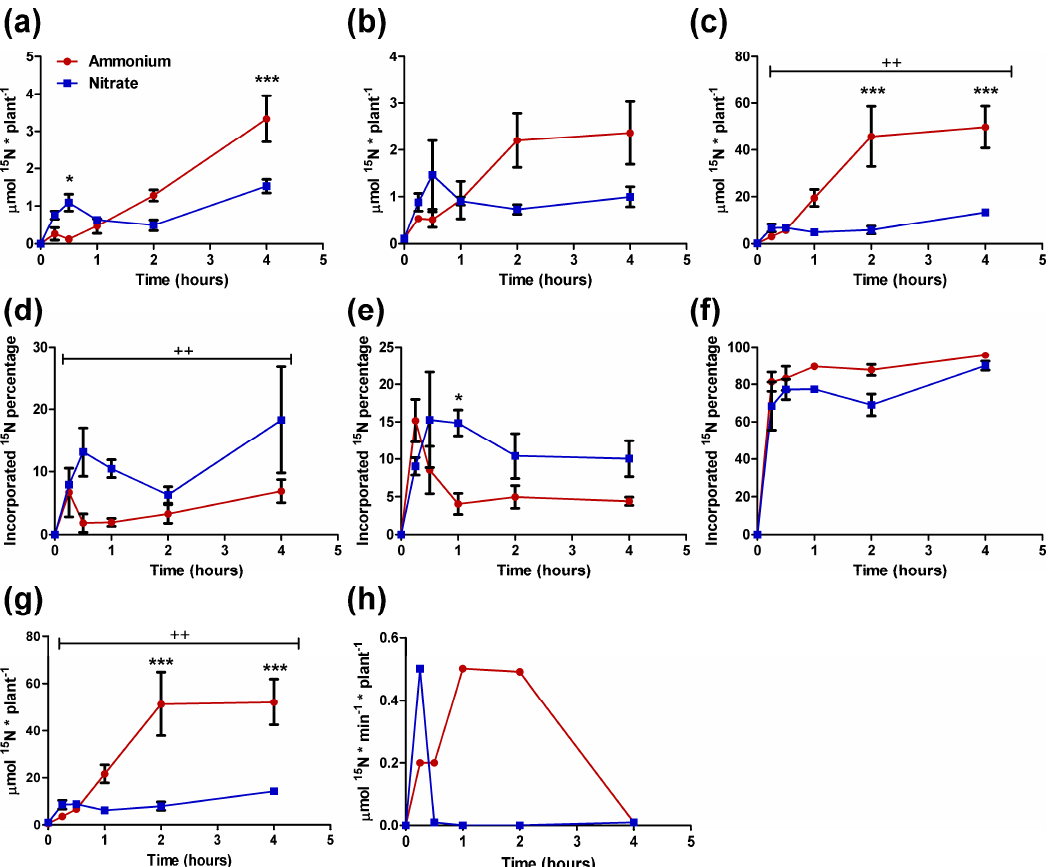
Figure 3. 15 N incorporation in different organs (needles, stem, and roots) of pine seedlings under the two nutrient treatments. The red line corresponds to 7.5 mM 15 N-labeled ammonium. The blue line corresponds to 7.5 mM 15 N-labeled nitrate. 15 N amount in needles ( a ); stems ( b ); roots ( c ); and the whole seedling ( g ). Percentage of 15 N contained in needles ( d ); stems ( e ); and roots ( f ) with respect to the amount in the whole seedling. 15 N Incorporation rate in the seedling ( h ). Differences between treatments were determined with a two-way ANOVA. Significant differences are indicated with crosses (++ at p < 0.01). Differences between treatments in each individual time point were determined with a Bonferroni post-hoc test. Significant differences are indicated with asterisks on top of the columns: * at p < 0.05; ** at p < 0.01, *** at p < 0.001. Error bars show SE with n = 3.